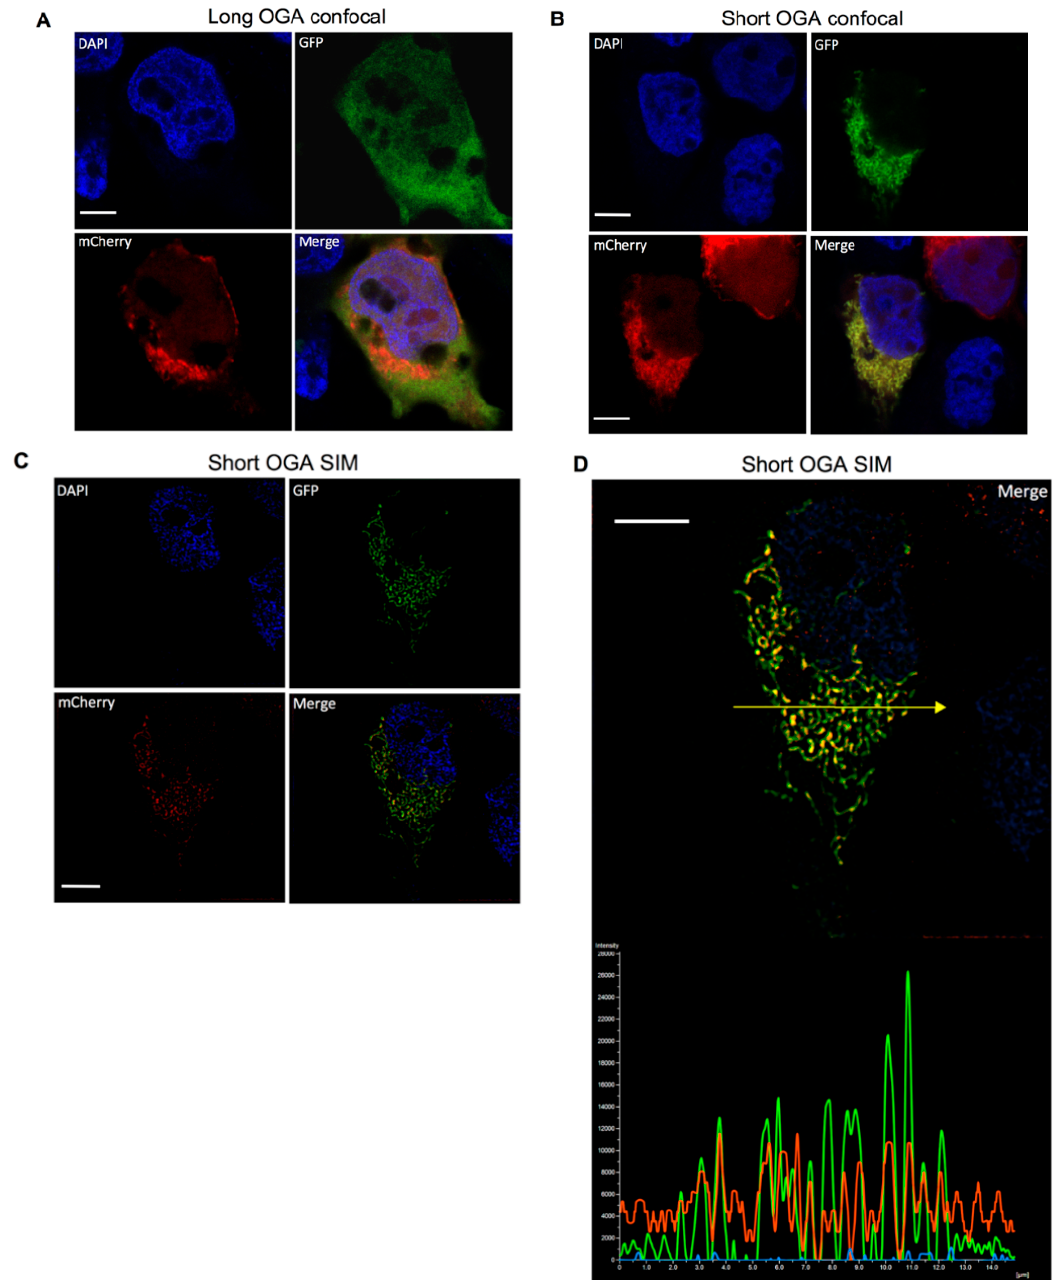
Figure 2. Detection of GFP-tagged long and short OGA isoforms in HEK-293T cells. HEK-293T cells were transfected with mitochondrial-targeted mCherry and either GFP-tagged short or long OGA isoforms, fixed, stained with DAPI for visualization of the nuclei (blue), and analyzed by confocal microscopy in the GFP (green) and mCherry (red) channels. Merge images are shown. ( A ) The long OGA isoform was detected in the cytosol and the nucleus but poorly co-localized with mito-cherry labeled mitochondria. ( B ) Co-localization of the short OGA isoform with mito-mCherry in a cell expressing GFP-tagged short OGA. ( C , D ) Structured illumination microscopy (SIM) confirmed localization of S-OGA in the mitochondria. ( C ) Separated SIM and merge images of this cell in the GFP, mCherry, and Dapi channels are shown. ( D ) Densitometric analysis of the different signals detected along the arrow shown on the upper panel indicates co-localization of S-OGA-GFP with mito-mCherry (green: S-OGA-GFP, red: mito-mCherry, blue: Dapi staining of the nucleus, white bar scale: 5 μ m). Representative images are shown.